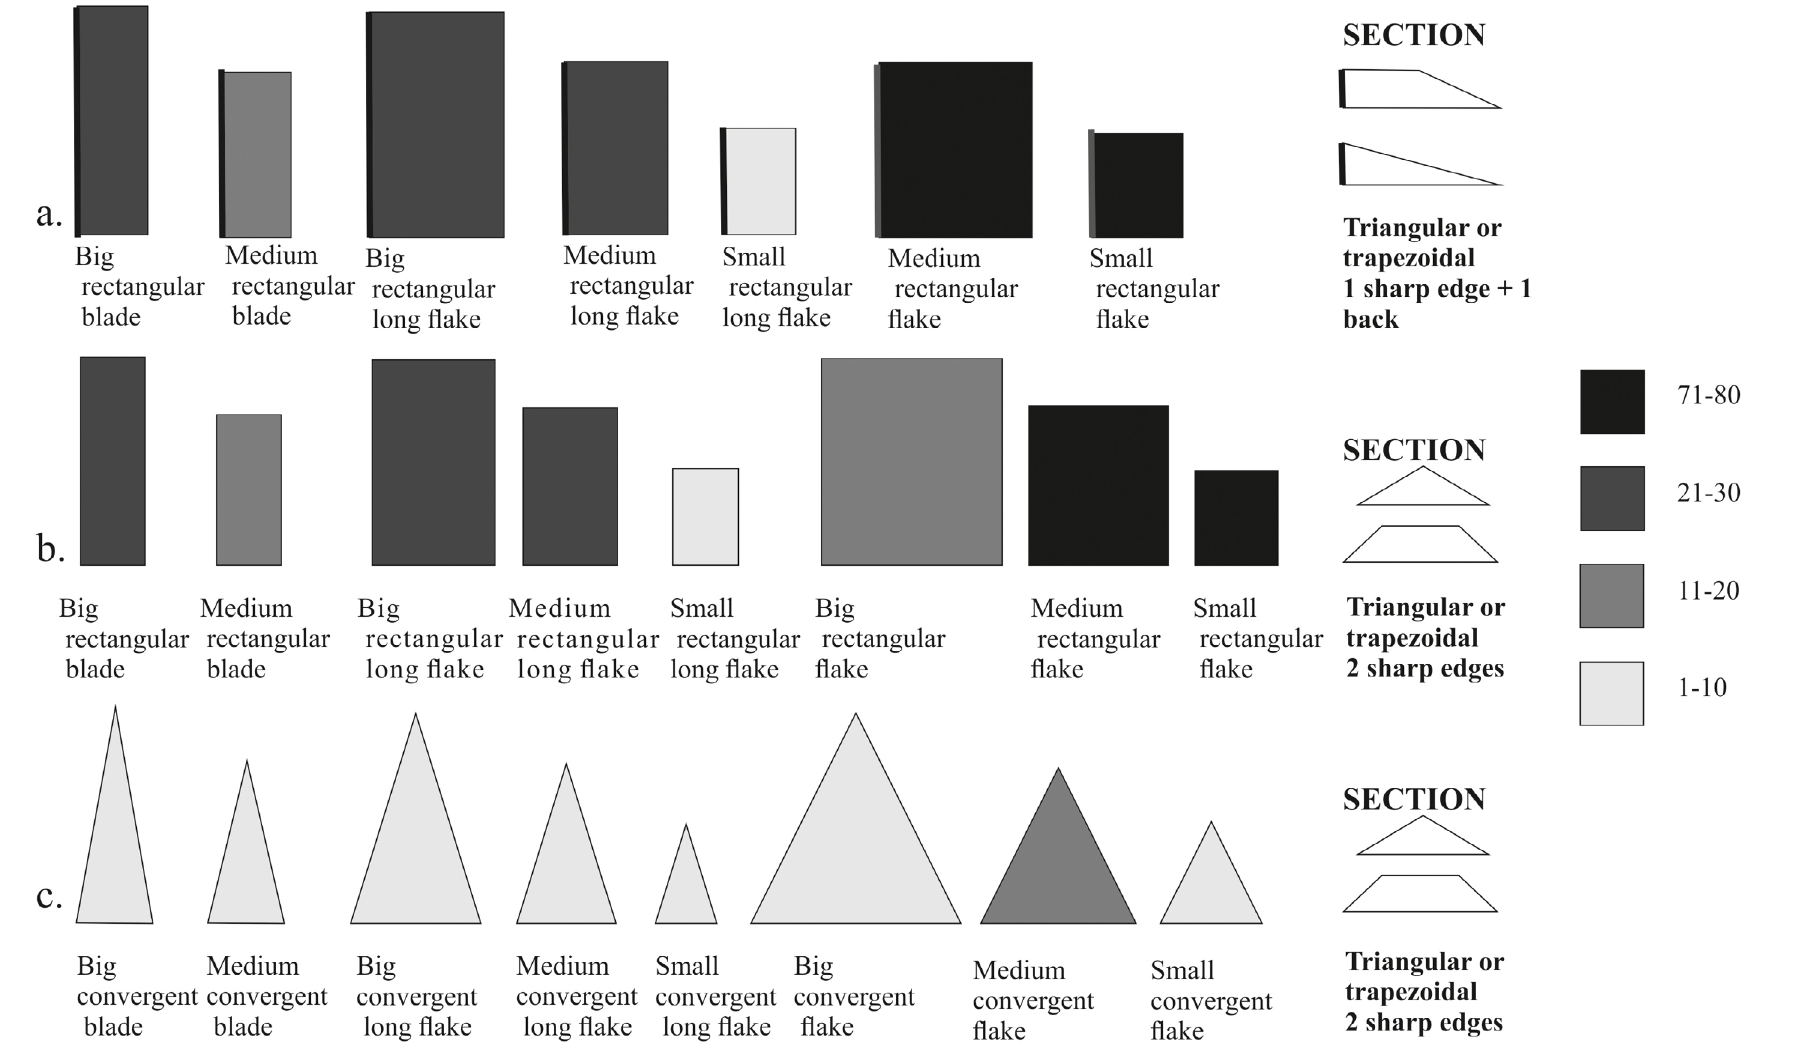
Figure 7. a. Type-blank A rectangular blanks with one cutting edge opposed to a backed side. b. Type-blank B: rectangular blanks with at least two cutting edge. c. Type- blank C: convergent blanks with at least two cutting edges (the scale of colour indicates the number of items: darker = more frequent and lighter = less